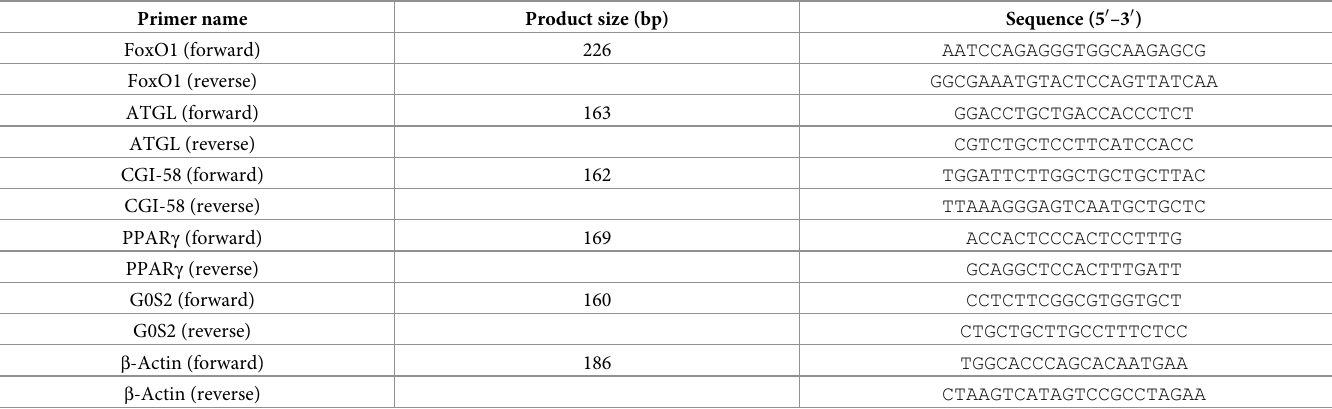
Table 1. Primer pairs used in the qPCR